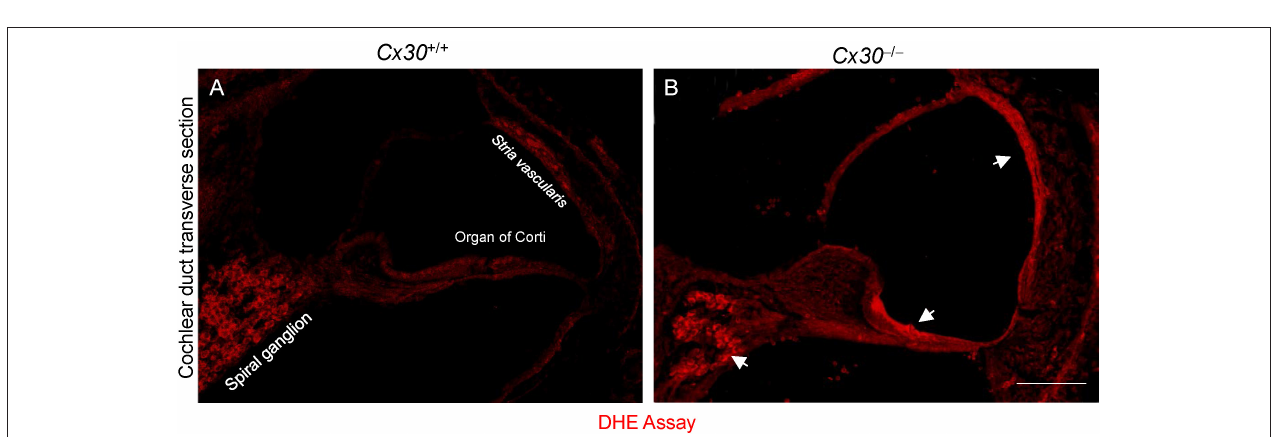
FIGURE 5 | Oxidative stress in Cx30 + / + and Cx30 − / − cochleae at P5. (A,B) Representative cochlear cryosections stained with DHE showing superoxide production (red fluorescence) in Cx30 + / + and Cx30 − / − cochleae. Arrows indicate increased fluorescence intensity in principal cochlear structures: Stria vascularis , organ of Corti, and spiral ganglion. Scale bar: 100 µ